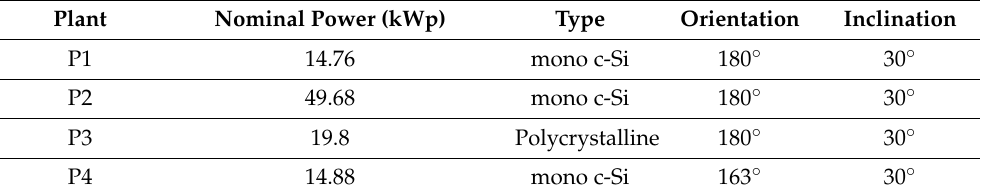
Table 1. Main characteristics of the PV plants. Note that P4 has an exposition of 17 ◦ East. Plant Nominal Power (kWp)